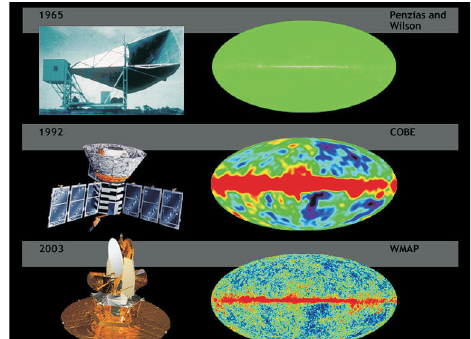
Fig. 3. Celestial map compiled in the azimuthal Fig. 4. Maps presenting the results of studies on the projection relict radiation (https://commons.wikimedia.org/wiki/ (http://www.skymaponline.net/instructions.html) File:BigBangNoise.jpg)